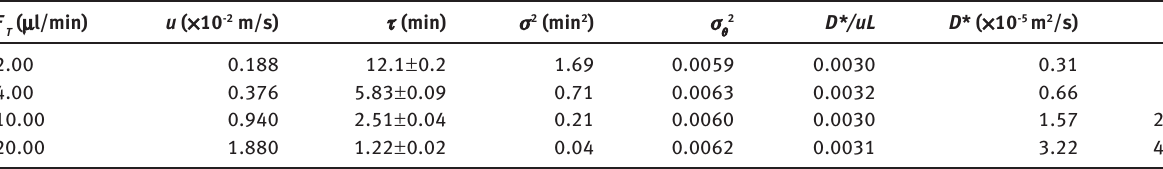
Table 5 Comparison of dispersion for multiphase RTDs at different flow rates.